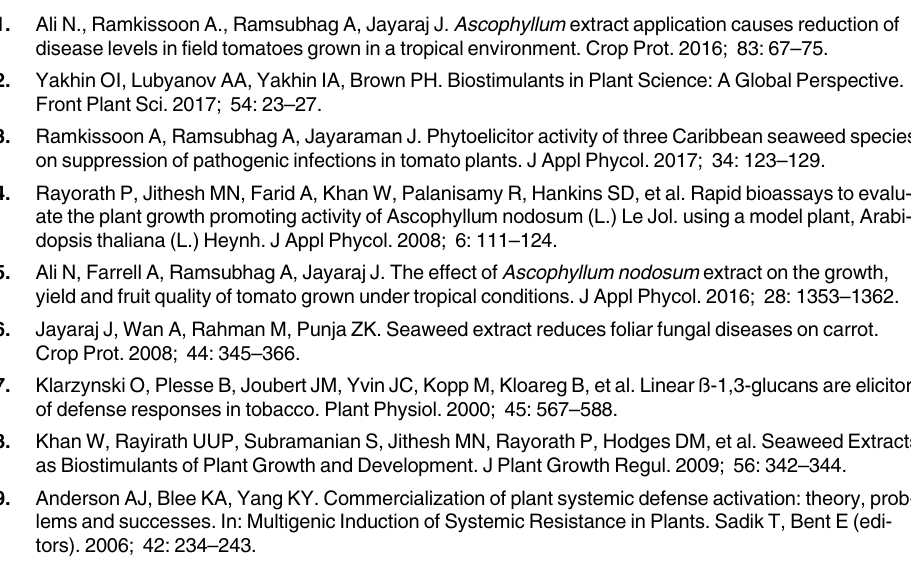
S1 Table. This is the S1 Table with the Oligonucleotide primers used in the study.